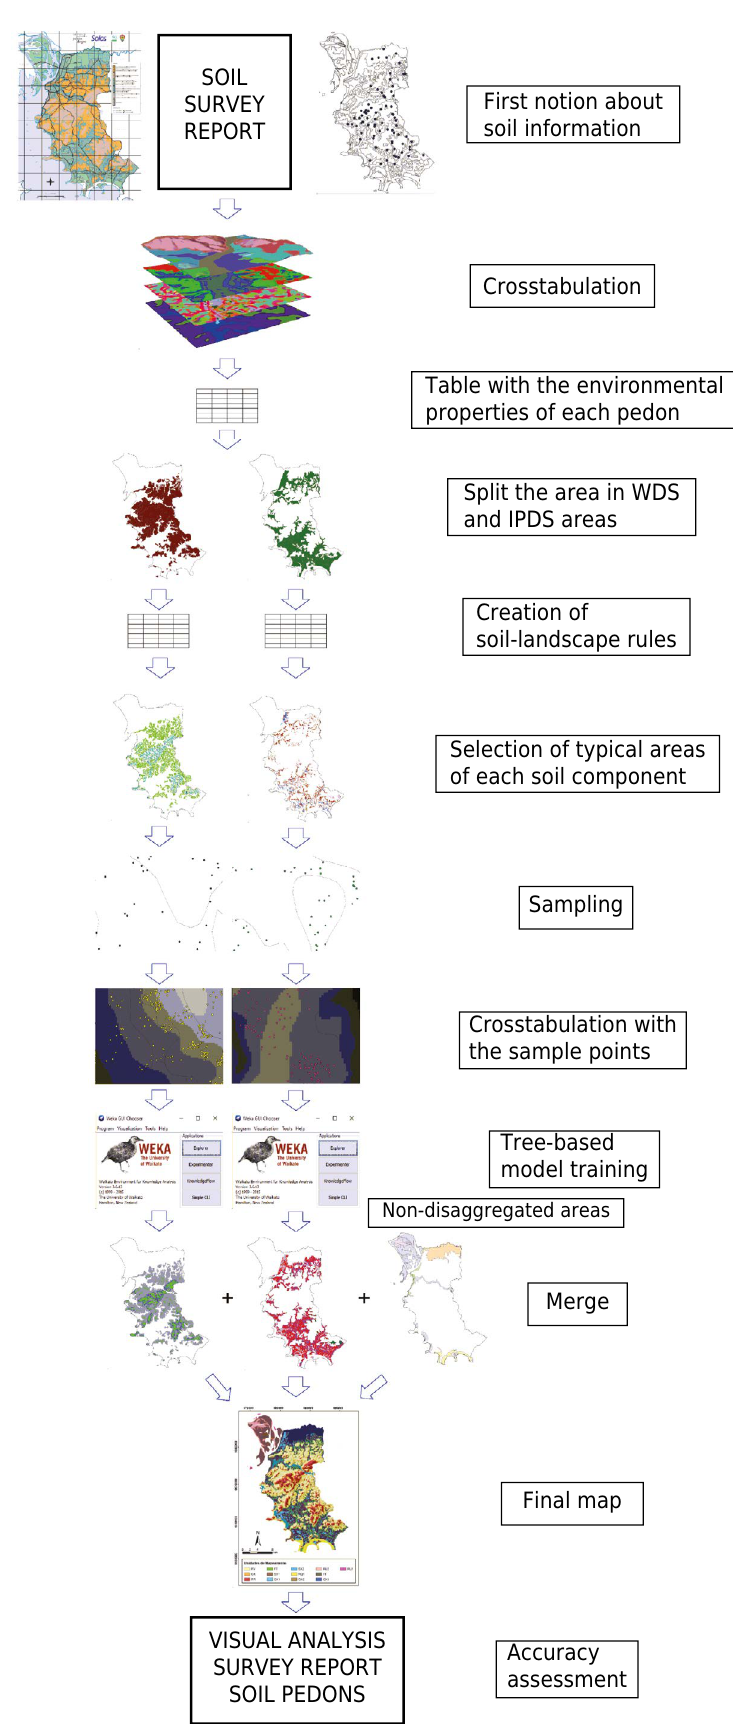
Figure 2. Schema of methodological steps for disaggregating soil map units in the Porto Alegre municipality